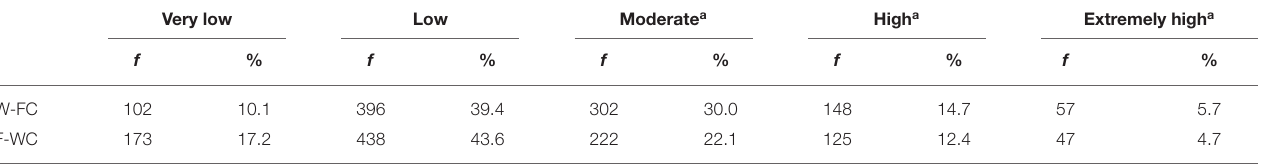
TABLE 4 | Work-family conflict and family-work conflict total score categorization ( N = 1,005). Very low Low Moderate a High a Extremely high